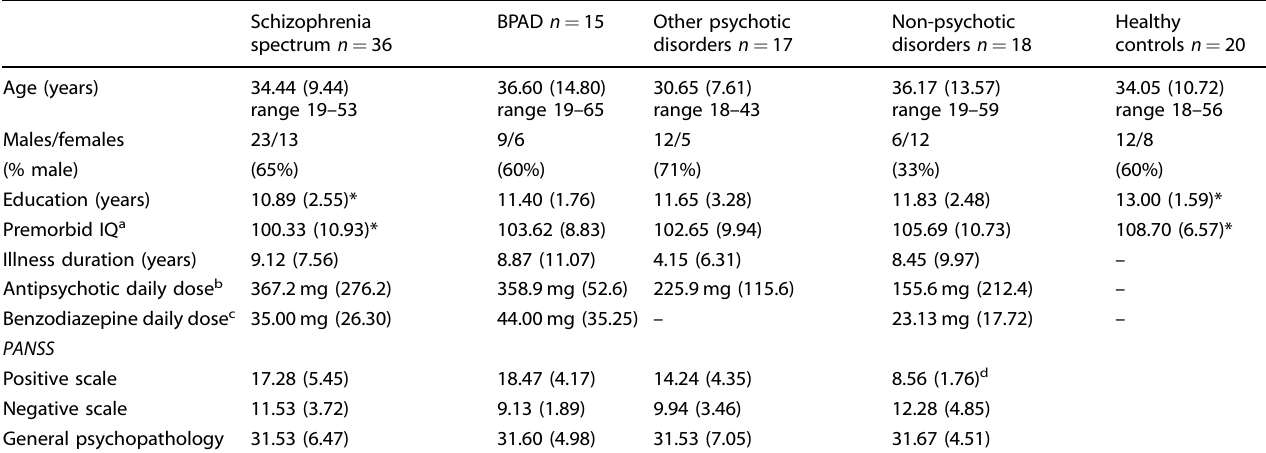
Table 1. Mean participant demographics and questionnaire scores by